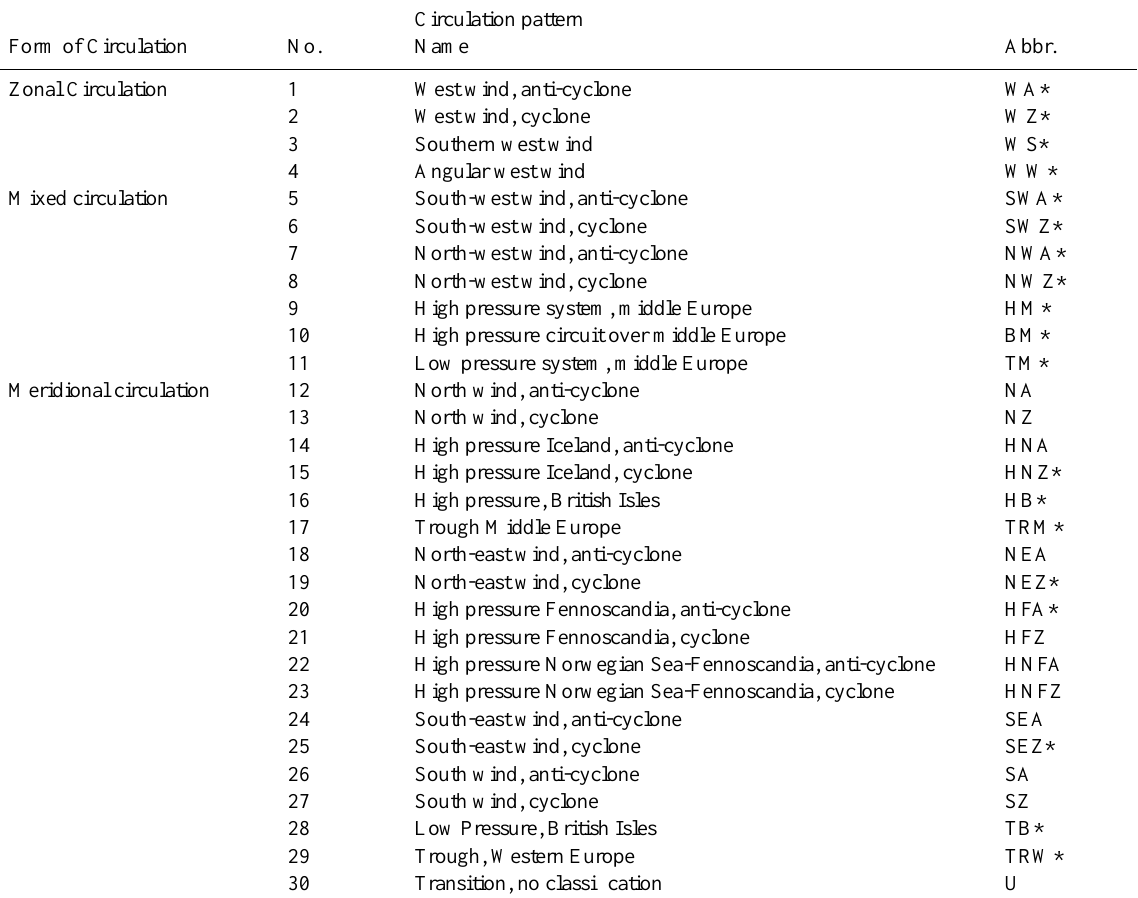
Table 2. Classification of the form of circulation and its specific pattern (* indicates circulation patterns which are relevant for AMS discharges in the Mulde